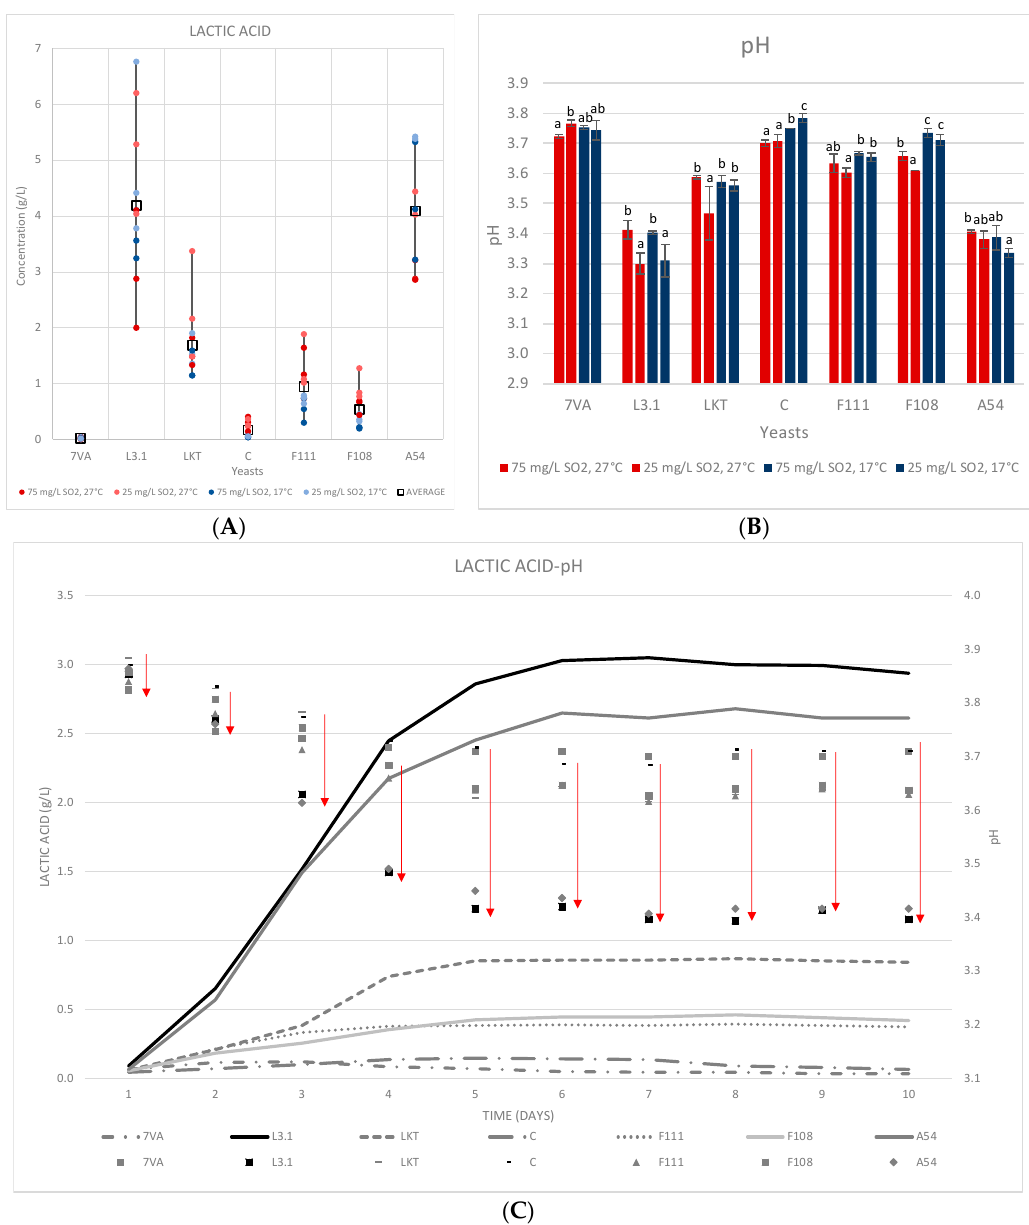
Figure 3. ( A ) The lactic acid produced in the 10 mL fermentations at two temperatures and two SO 2